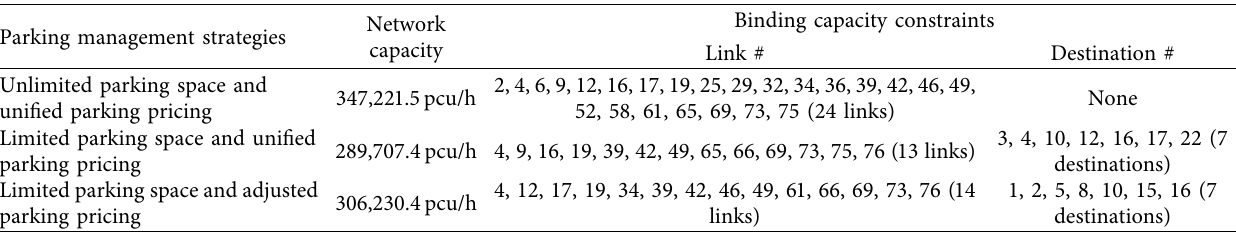
Table 9: Summarized results under different parking management strategies in